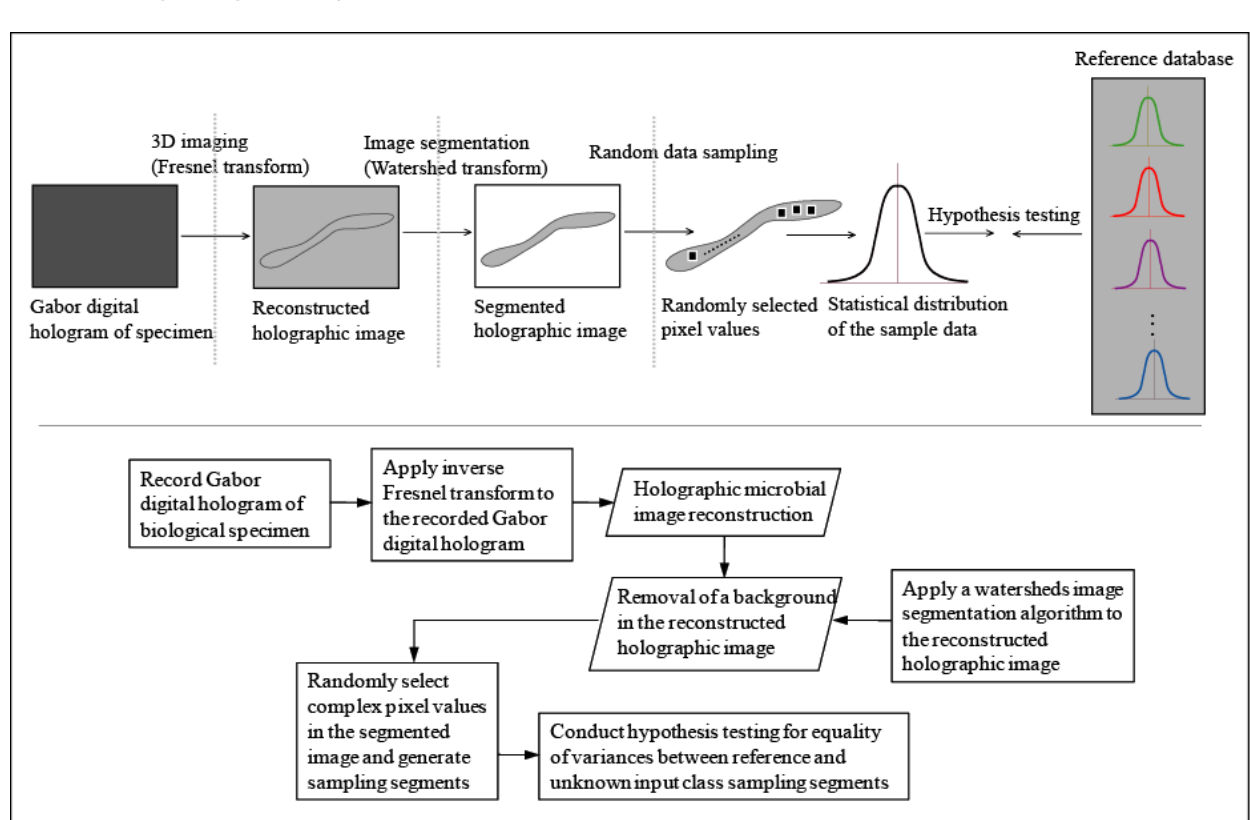
Figure 2. Statistical methodology to implement the presented three-dimensional microbial sensing/recognition system